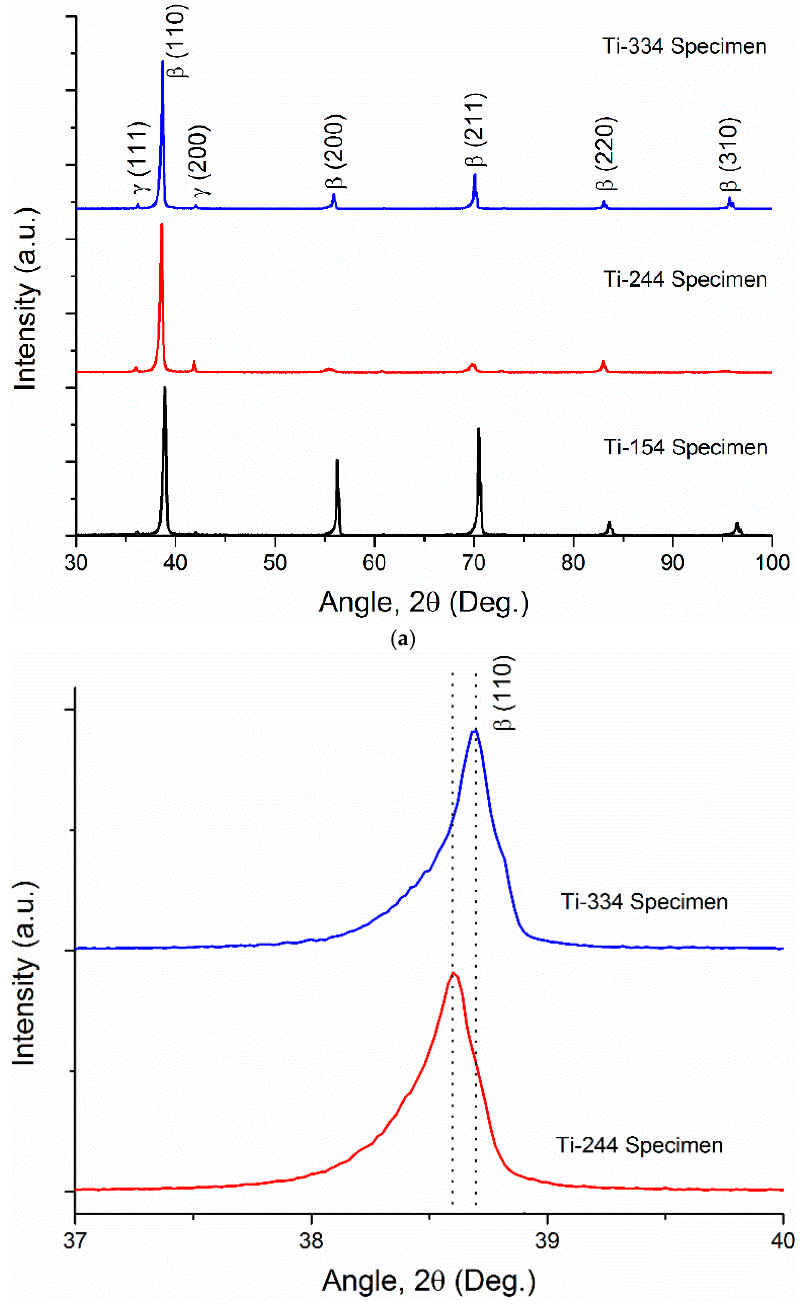
Figure 5. X-Ray Diffraction (XRD) of ( a ) Ti-154, Ti244 and Ti-334 specimens; ( b ) the relative peak shift of β (110) peak position.